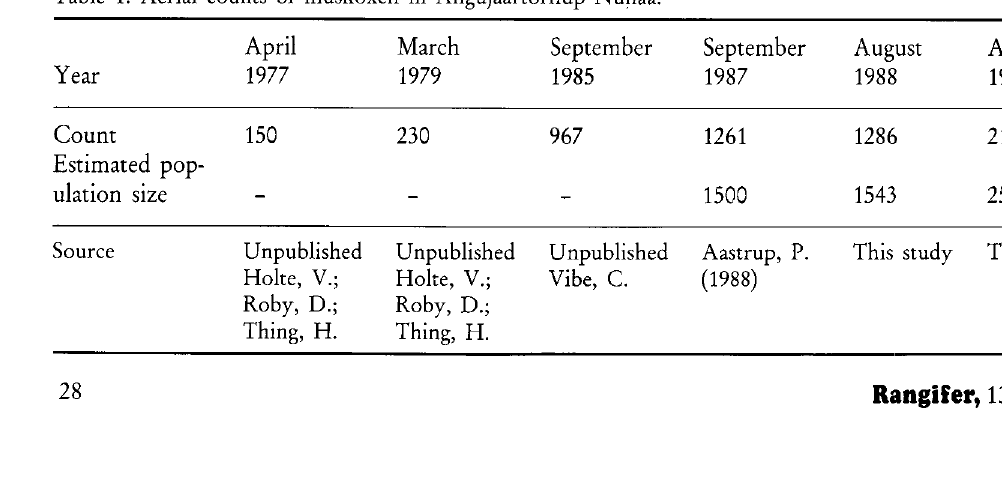
Fig. 1. Location of the study area and distribution of muskoxen in Angujaartorfiup Nunaa. plant production; several broad east-west orien tated valleys hold large brailed rivers feeding melt water from the Inland Ice to Kangerlussu- aq fiord. Towards the southwest the terrain rea ches elevations up to 1200 m above sea level. The climate is continental with high seasonal temperature amplitudes and a very low annual precipitation in the range of 1500 mm. Snow cover is limited and daily mean temperatures range above 0°C for about 4 months of the year (Thing, 1984; Langager, 1990). Table 1. Aerial counts of muskoxen in Angujaartorfiup